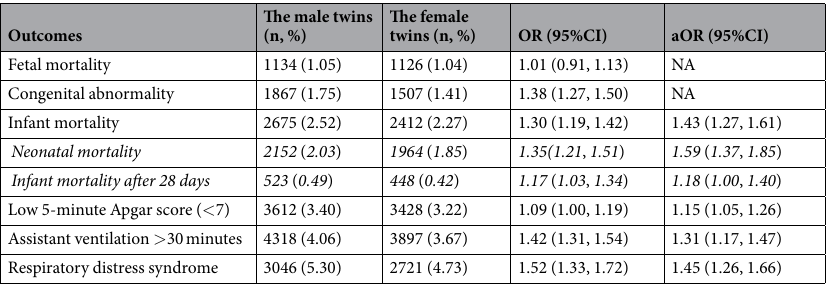
Table 3. Mortality and Morbidity in Mixed-Gender Twins: Comparison Between Male and Female Co-twins. OR: Odds Ratio; aOR: Odds Ratio adjusted by birth weight, birth order and methods of